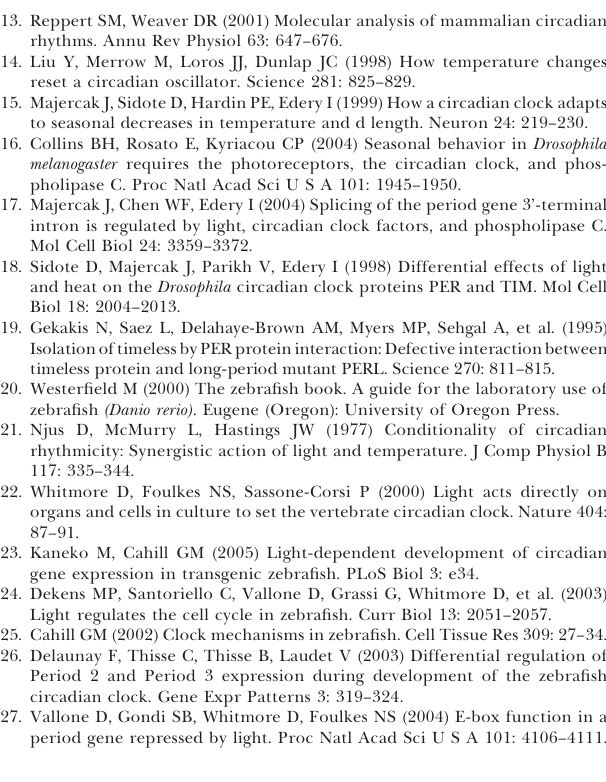
Figure S3. Analysis of Recombinant Zebrafish CLOCK